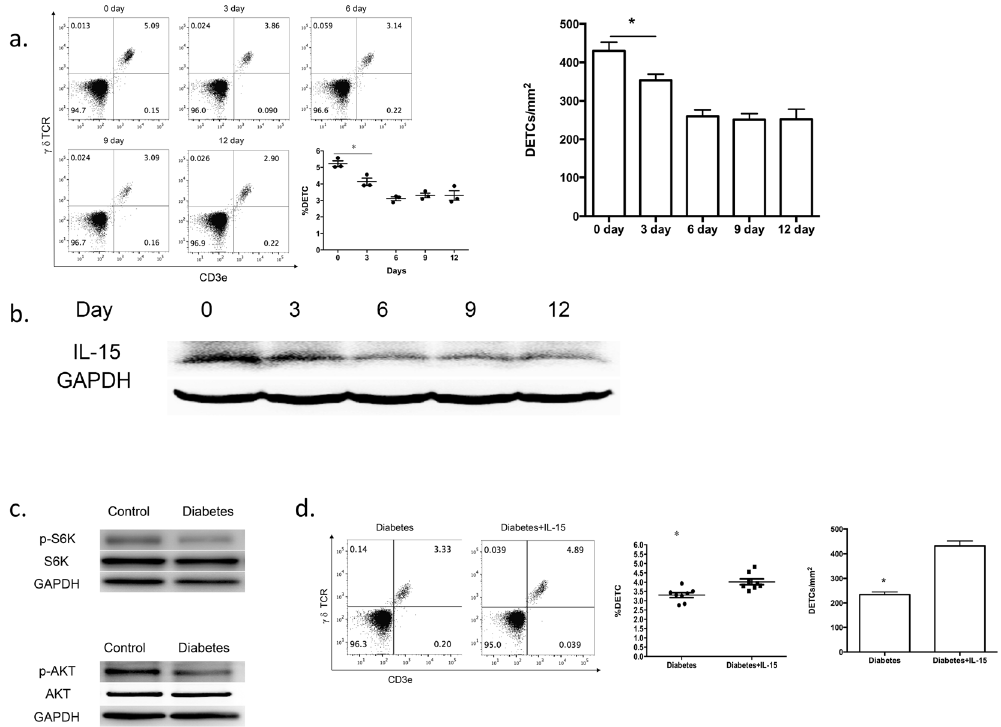
Figure 4. Impaired mTOR pathway and weakened IL-15 production correlate with altered DETC homeostasis in diabetic mice. ( a,b ) 6–8 weeks wild-type male C57BL/6J mice were administered STZ for 6 days. At day 0, 3, 6, 9, and 12 after STZ treatment, epidermal sheets were excised for assessing the number of DETCs by FACS (panel a) and the production of IL-15 by Western blotting (panel b). ( c ) The phosphorylated and total expression of S6K and Akt in the epidermis of diabetic mice and wild-type controls was assessed by means of Western blotting. ( d ) IL-15 (5 μ g) or vehicle control was intradermally injected daily on the back skin of STZ- treated mice for 3 days, and epidermal sheets were excised for assessing the number of DETCs by FACS. All data represent at least three independent experiments and each experiment includes 6 animals (3 control and 3 experimental mice). All error bars represent mean ± SEM. * P <